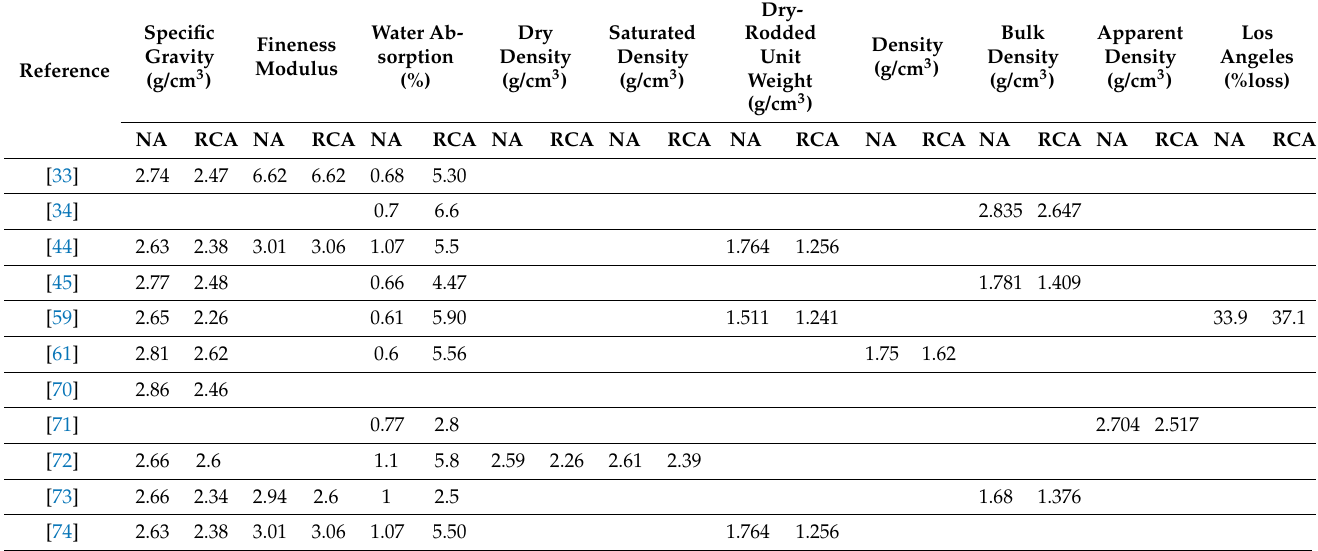
Table 1. Physical specification of NA and RCA.